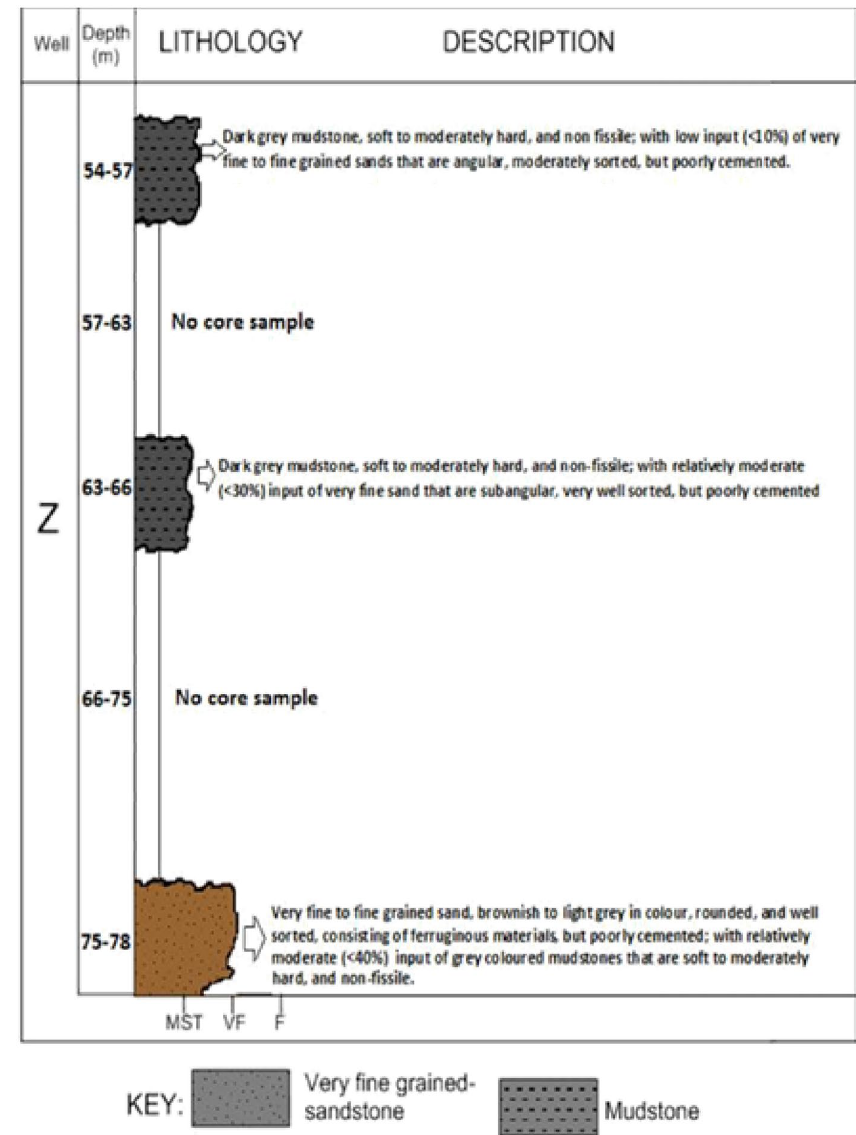
Fig. 5 Litho-section of core samples at Ajegunle A4 (Well